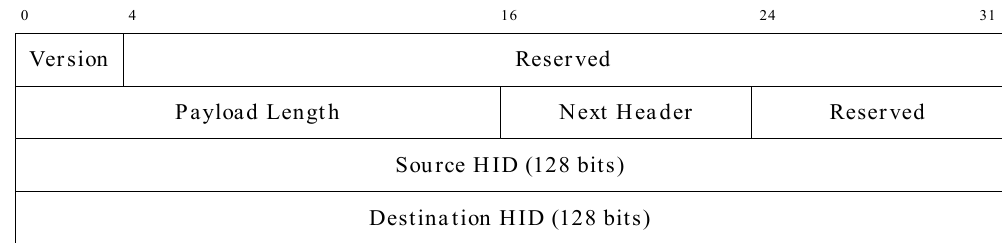
Figure 9. Identity header format.